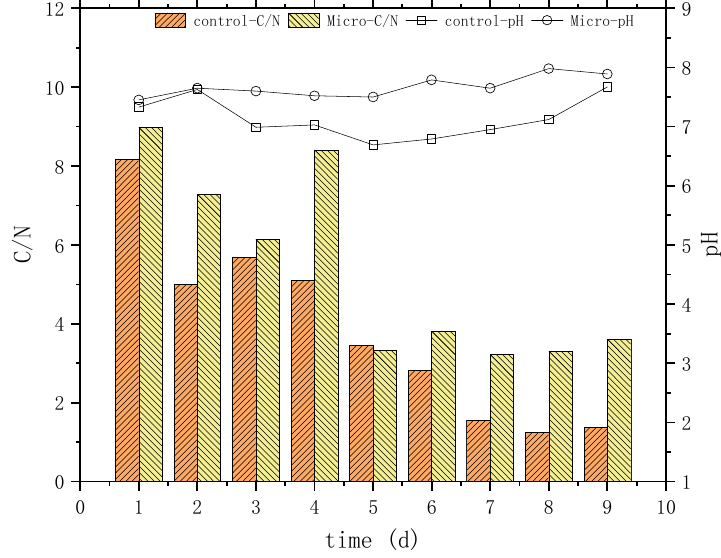
Figure 4. Variation characteristics of C/N and pH under microaerobic condition. The variation characteristics of protein and polysaccharide concentrations under microaerobic conditions are shown in Figure 5. The concentration of polysaccharides increases with the increase in time, indicating that microaerobic conditions can effectively promote the hydrolysis of POM to release more polysaccharides. With the increase in reaction time, the concentration of protein increases rapidly in the first 3 days and fluctuates in a small range later. It may be because the microaerobic conditions not only promote the hydrolysis of particulate organic matter to release more water-soluble proteins, but also promote the growth of protein-fermenting bacteria to further convert more soluble proteins into volatile fatty acids (VFAs), NH 4 + -N, and so on, resulting in fluctuations in the concentration of soluble proteins. Compared with the control group, microaerobic conditions were more conducive to promoting the action of POM in hydrolysing bacteria to release more polysaccharides and proteins, indicating that microaerobic conditions could more effectively improve the biological activity of protein and polysaccharide